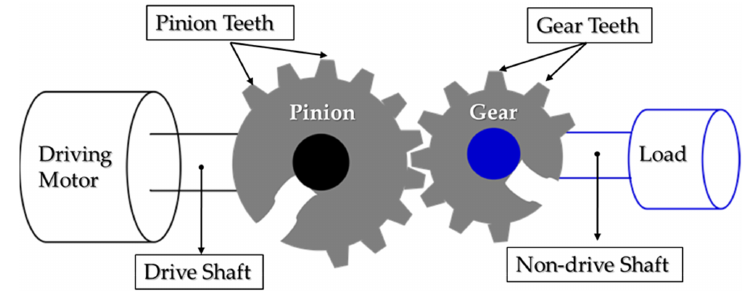
Figure 1. The spur gearbox model.